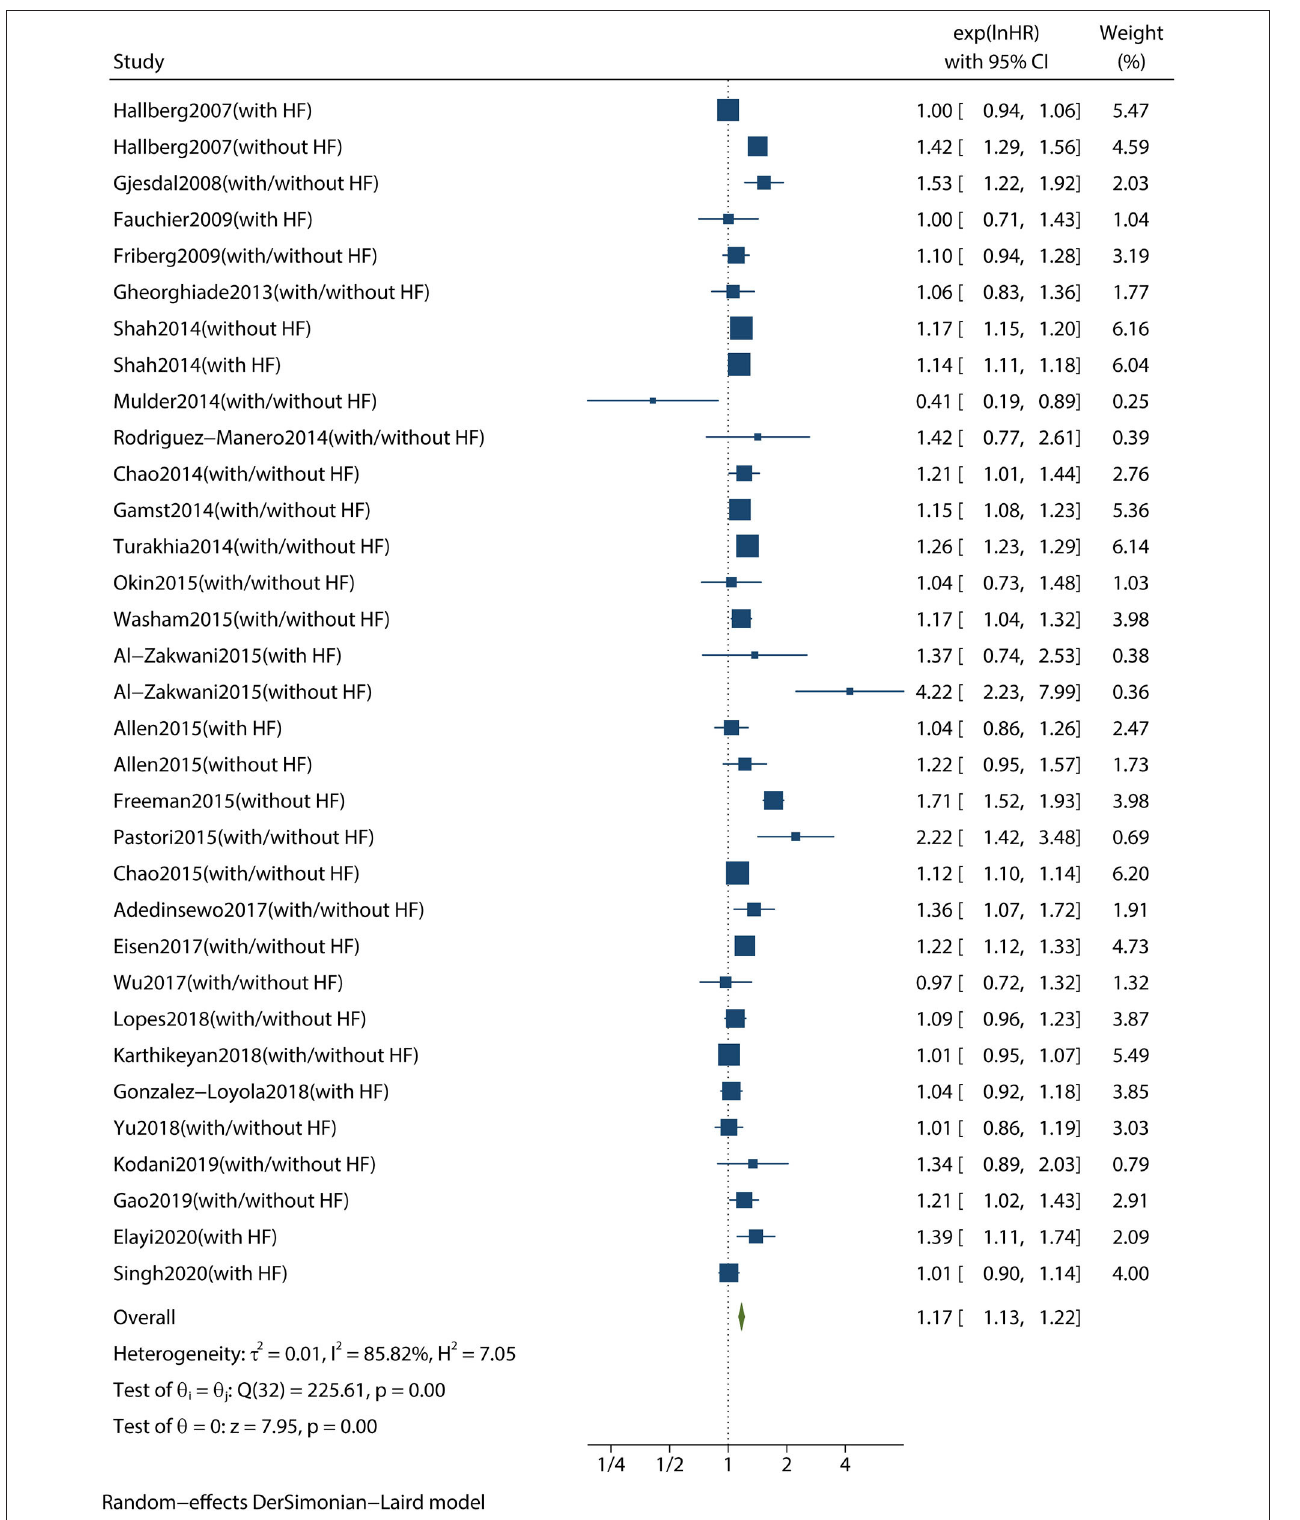
FIGURE 2 | Forest plot showing the effect of digoxin therapy compared with no digoxin therapy on all-cause mortality in patients with AF, regardless of concomitant HF. AF, atrial fibrillation; HF, heart failure; HRs, hazard ratios; CIs, confidence intervals.